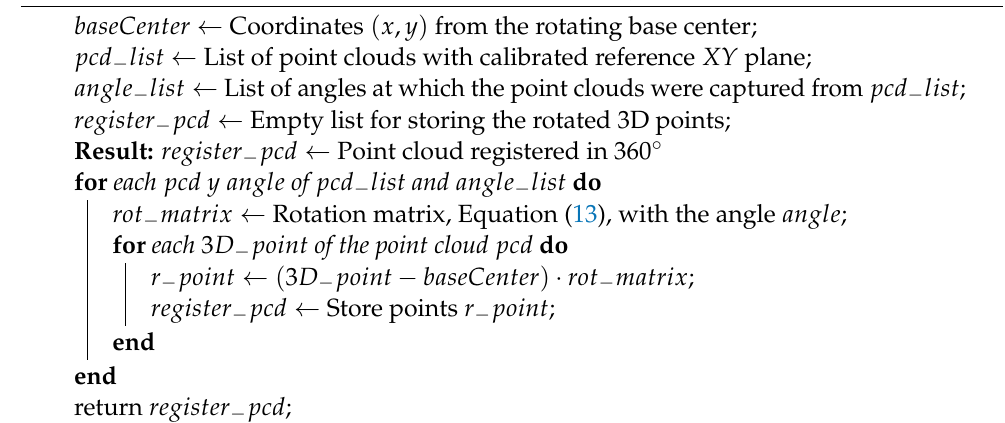
Algorithm 7: Rotation of point clouds for the 360 ◦ registration